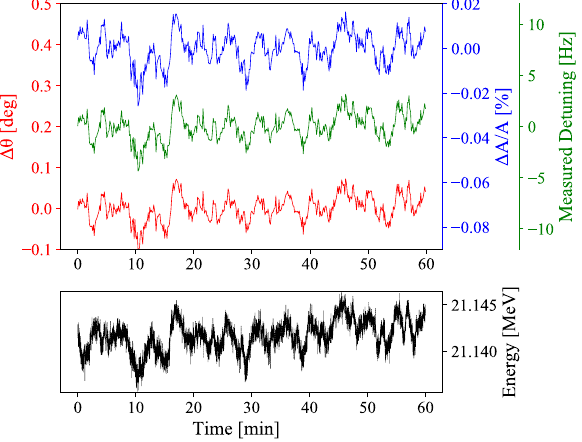
FIG. 5. Long term pulse-to-pulse amplitude (blue), phase (red) and detuning (green) during the flat-top of the rf pulse on ML2 that operated at 7.5 MV.